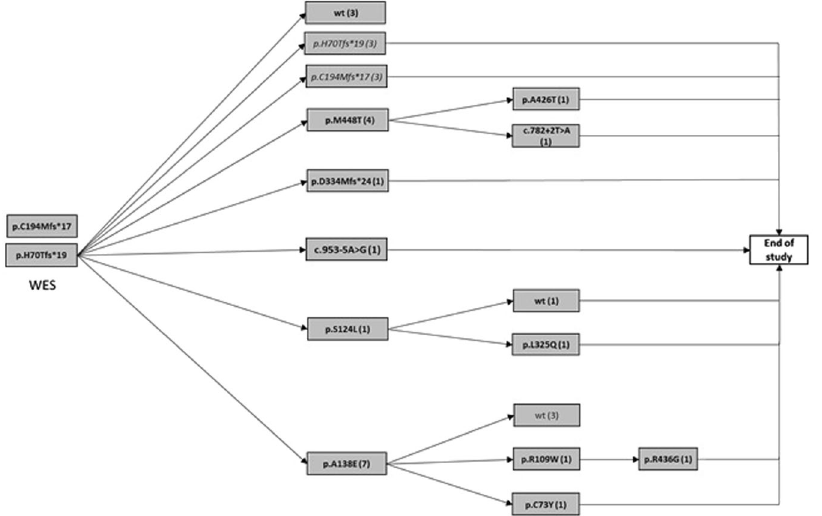
Figure 2. Summary of findings during cascade TMPRSS mutation screening by ISVS in a cohort of HI subjects. WES – whole exome sequencing; arrows – cycles of Real Time PCR screening; filled boxes - variants found by Sanger sequencing, (number of samples with each variant is given in parentheses); italics – variants observed at a previous